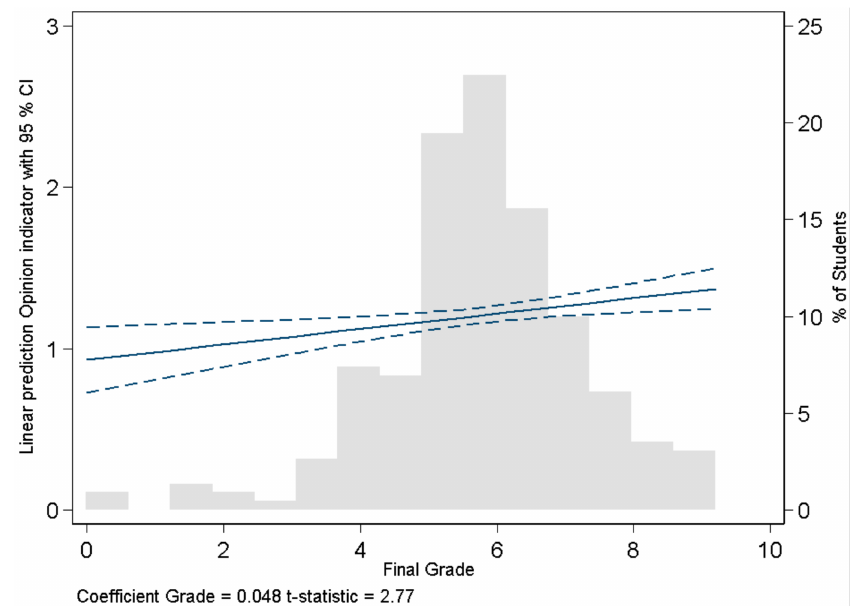
Figure 3. Marginal effects plot and histogram of final grades of the Chemistry course